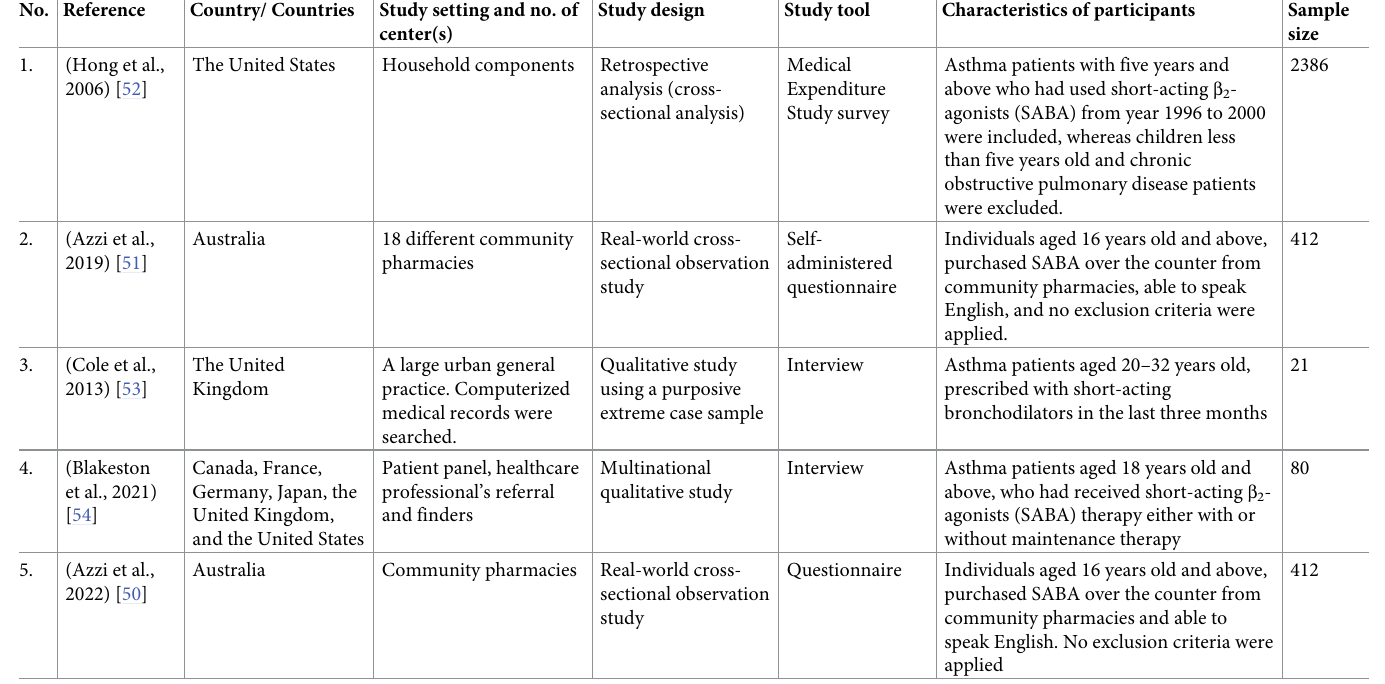
Table 1. Characteristics of studies included in this systematic